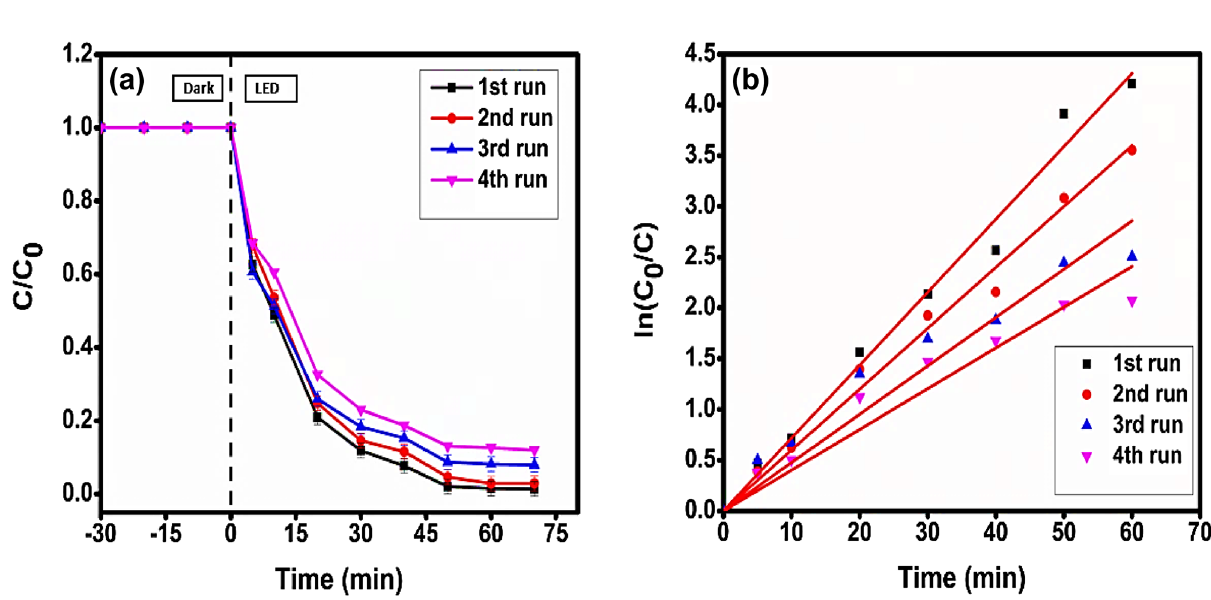
Figure 13. ( a ) Degradation profile and ( b ) kinetics plot up to four cycles of reused photocatalyst for MG dye degradation.